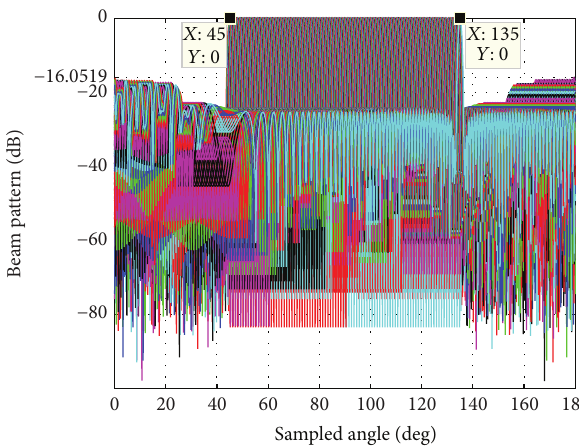
Figure 6: Beam pattern optimized by BPSO firstly and PSO sec- ondly.